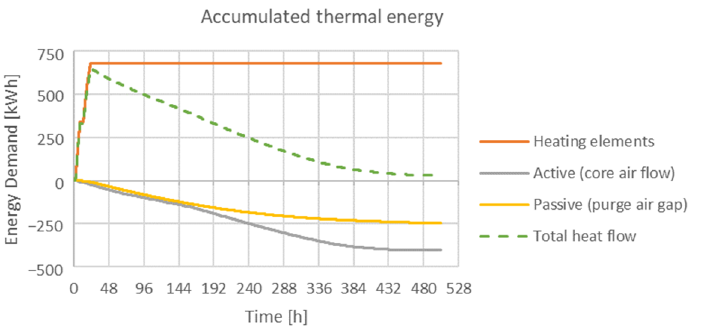
Figure 12. HTSS: simulated thermal energy with full charging and subsequent active and passive heat dissemination for space heating.